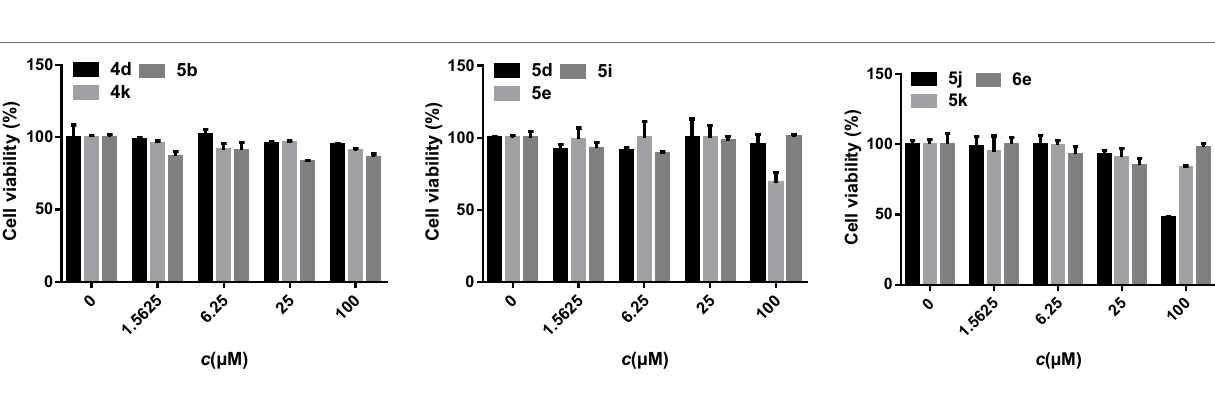
FIGURE 2 | Scanning electron microscopy (SEM) micrographs of Exserohilum turcicum hyphae. (A) Blank control, (B) Treated by 4k at 50 μ g/ml, (C) Treated by 5e at 50 μ g/ml, and (D) Treated by 5k at 25 μ g/ml.